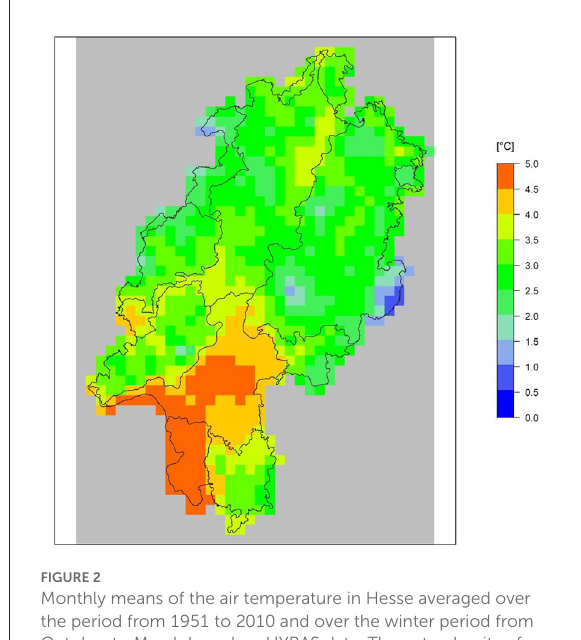
FIGURE2 Monthly means of the air temperature in Hesse averaged over the period from 1951 to 2010 and over the winter period from October to March based on HYRAS data. The natural units of Hesse according to Otto Klausing are shown as polygons in